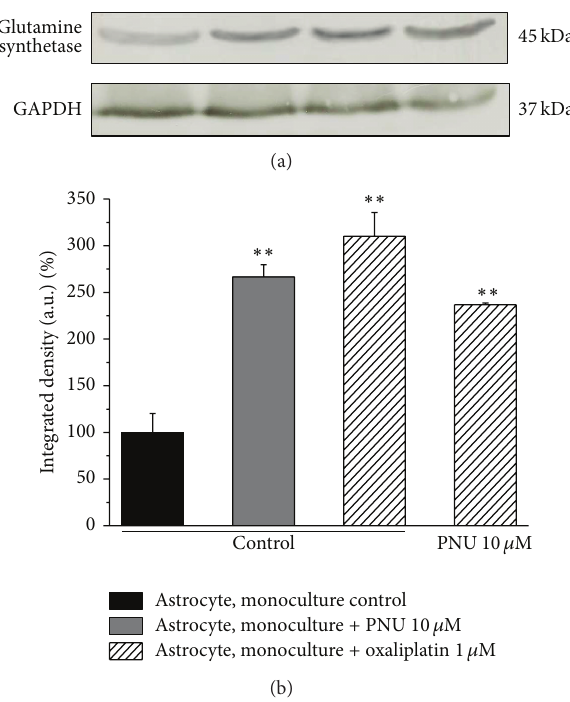
Figure 5: Glutamine synthetase expression level in astrocyte mono- culture. Astrocytes were separately treated with 1 𝜇 M oxaliplatin, 10 𝜇 M PNU or coincubated with oxaliplatin and PNU for 48 h. Densitometric analysis (b) and representative western blot (a) are shown. GAPDH normalization was performed for each sample. Values are expressed as the mean ± S.E.M. of 3 experiments. One- way ANOVA was performed followed by a Bonferroni significant difference procedure. ∗∗ 𝑃 < 0.01 versus